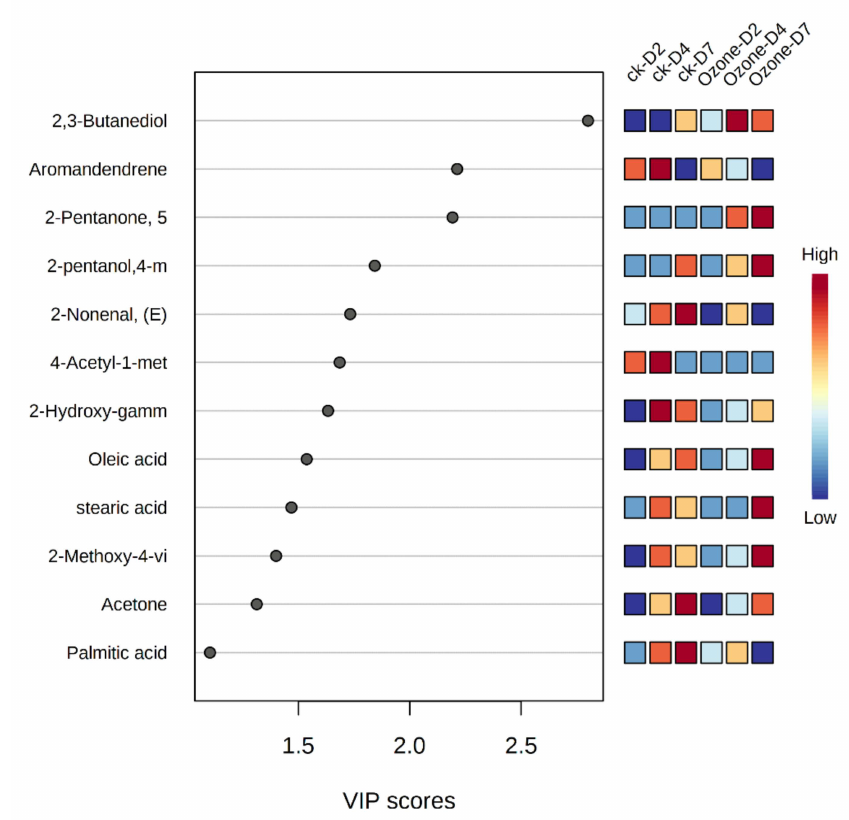
Figure 6. Variable importance in the projection (VIP) scores for germinating barley at zone treatment. VOCs was shown above with variable importance in projection (VIP) > 1.2. Red means a higher abundance of metabolites and blue means a lower